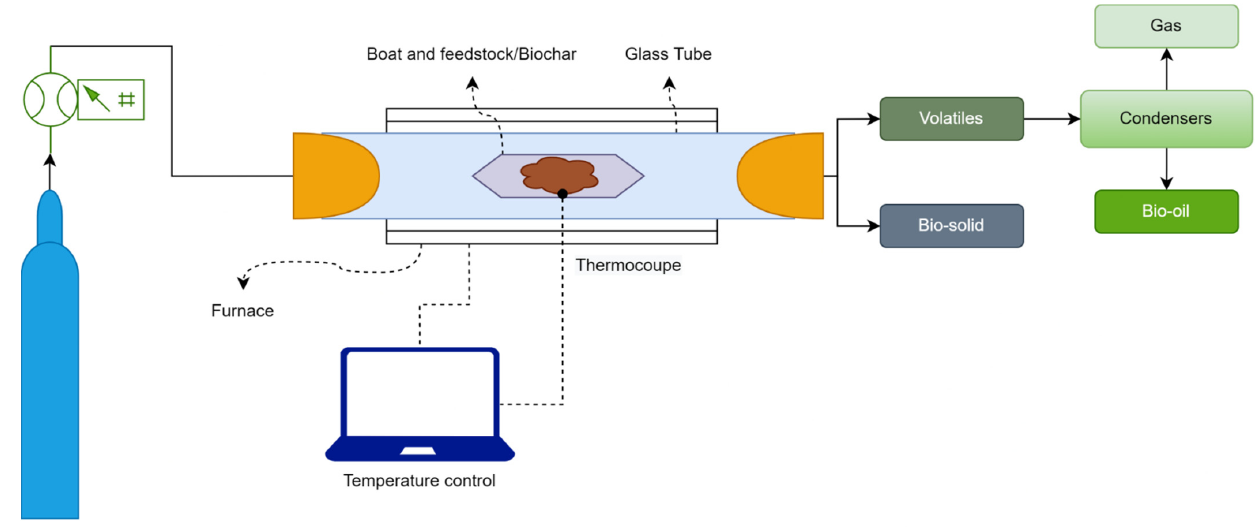
Figure 7. Setup of bio-char production through the co-torrefaction process adapted from [87].